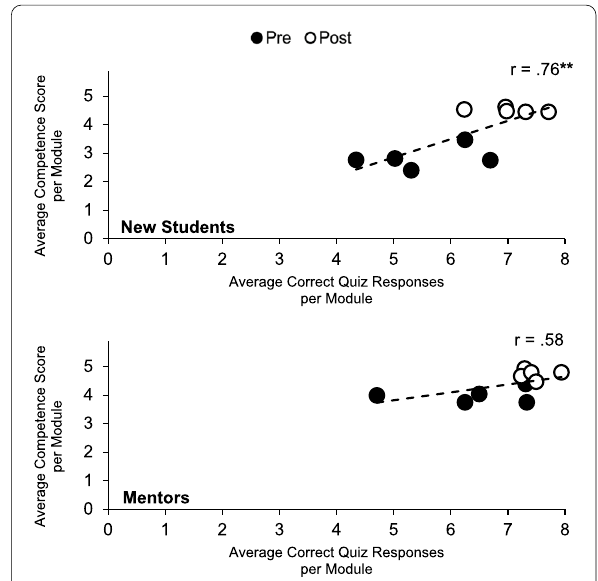
Fig. 11 Correlation of Student Performance (iClicker) and Competence (REMS Survey) Scores. Correlated performance and competence scores of new students (top, N 54) and Mentors = (bottom, N 12) in the REMS 2016–2018 programs. Each dot = represents the coordinate score ( x average correct quiz responses, = y average competence score) for a REMS module (e.g., ocean = acidification, marine bioacoustics). Black dots are pre-program scores, and white dots are post-program scores. ** p =